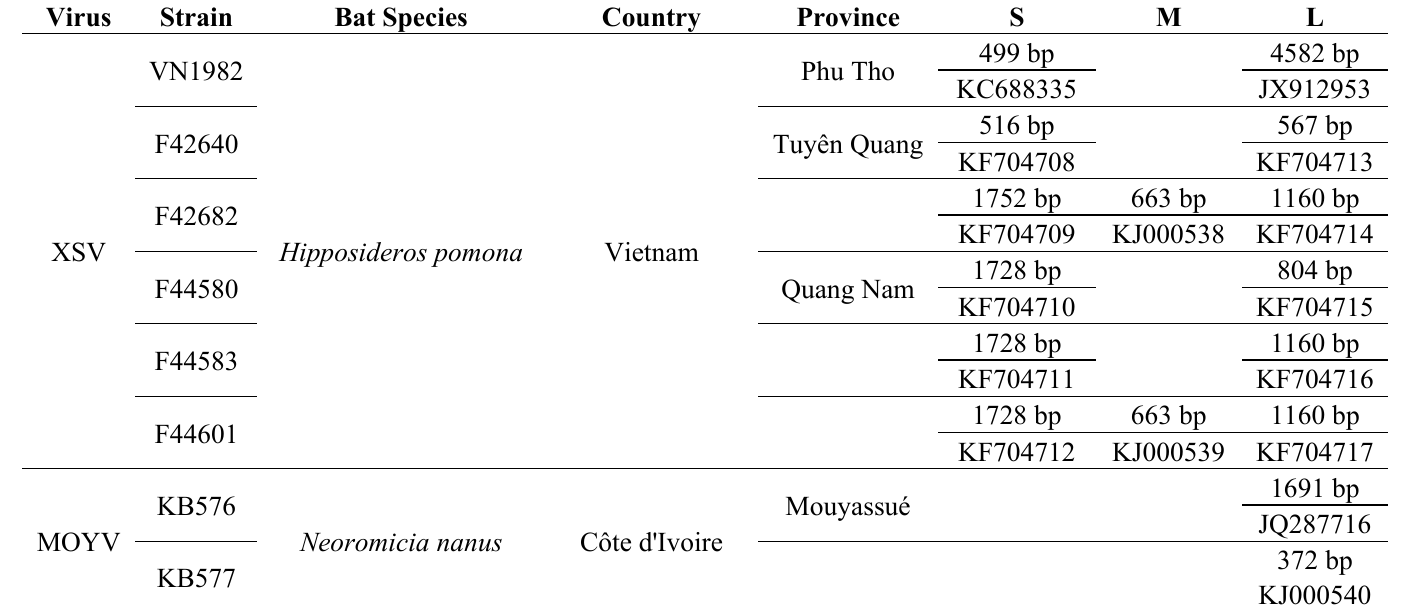
Table 2. Xuan Son virus and Mouyassué virus in insectivorous